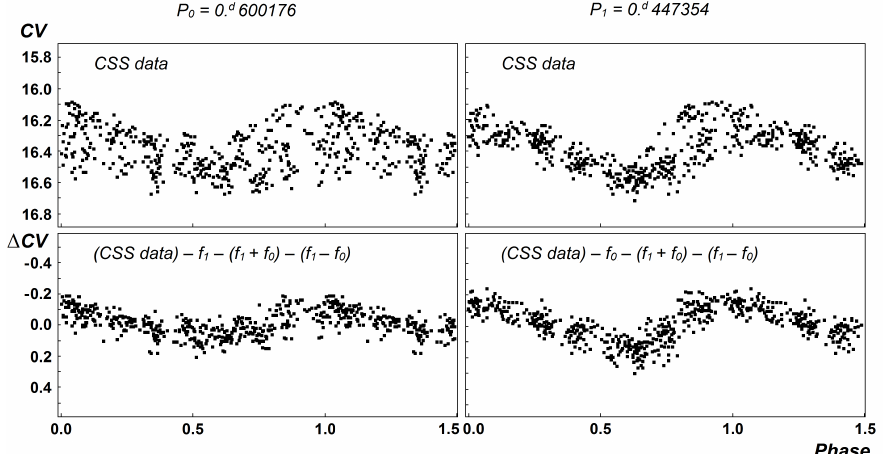
Fig. 1. The light curves of USNO-B1.0 0822-0766869 (Khruslov 2015b, No. 103). Upper panels: raw data; lower panels: the folded light curves with the other oscillation pre-whitened.